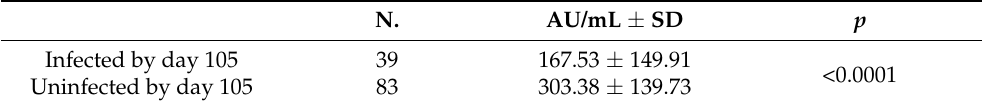
Table 4. Anti-SARS CoV-2 antibody titer mean (AU/mL) ± standard deviation (SD) at day 31 in vaccinated subjects who then developed SARS-CoV-2 infection compared with levels detected in subjects still uninfected at 105 days post-administration of BNT162b2 second doses.